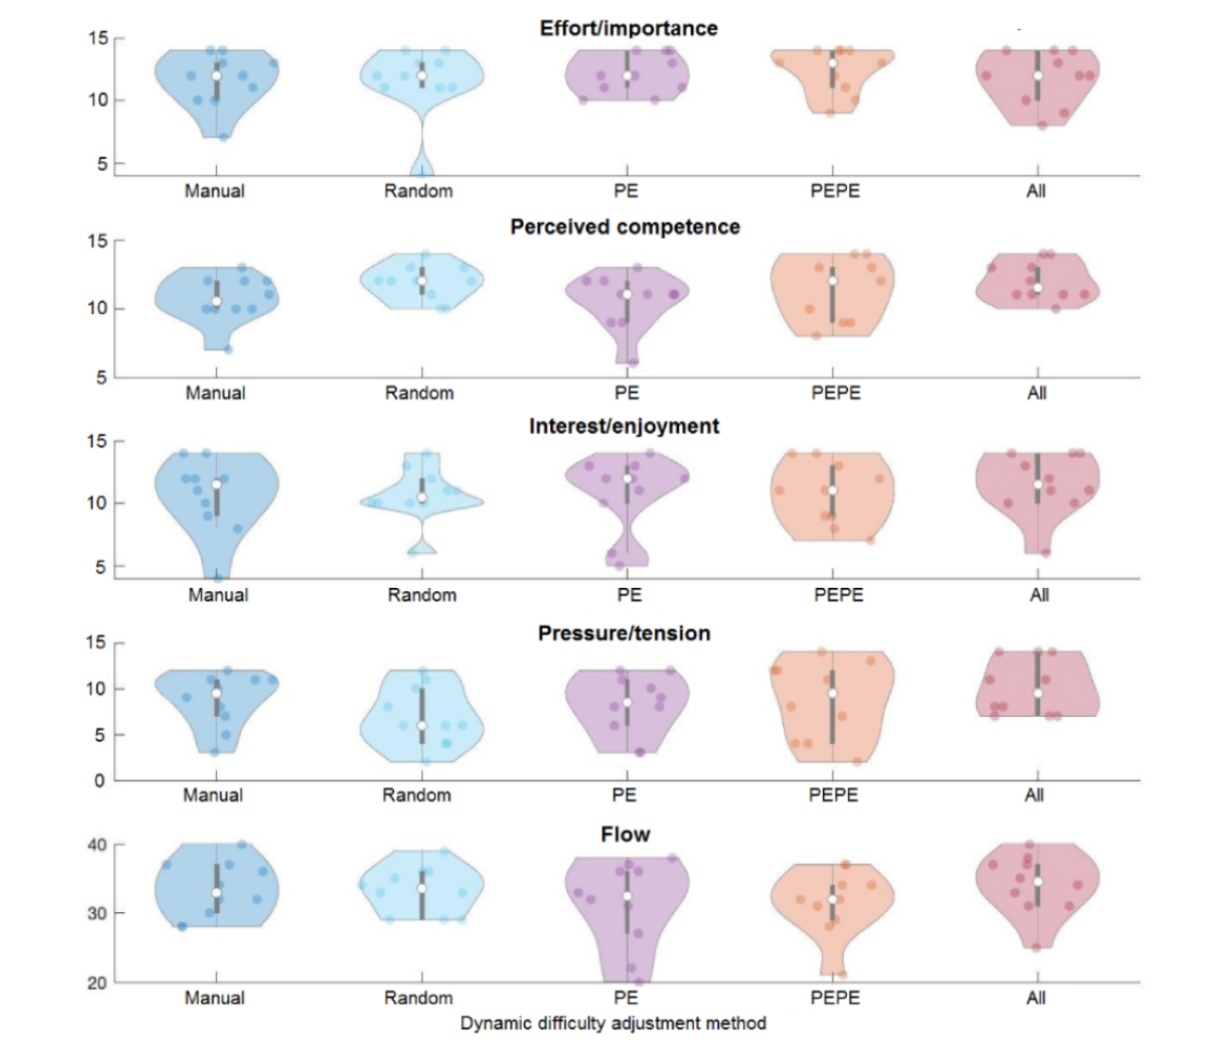
Figure 3. Violin plot of postexperiment self-report questionnaire outcomes. all data: based on physiology, personality, and performance. Each participant is indicated as a dot. The first four questionnaire outcomes have a possible range of 2-14, whereas flow has a possible range of 8-40. PE: adjustment based on performance; PEPE: adjustment based on personality and